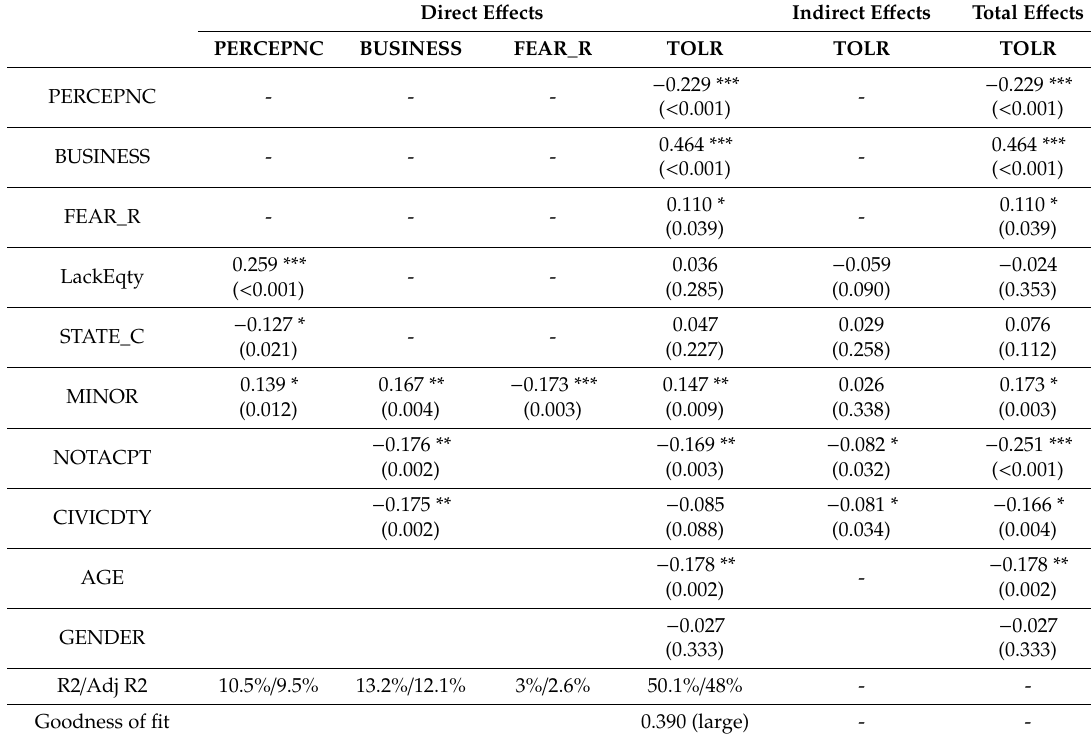
Table 5. Path coe ffi cients with p